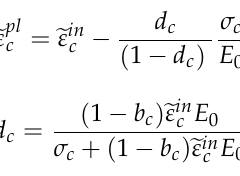
Figure 10. Comparison of experimental and analysis results using concrete damaged plasticity model with respect to foam density in: ( a ) tension; ( b ) compression.